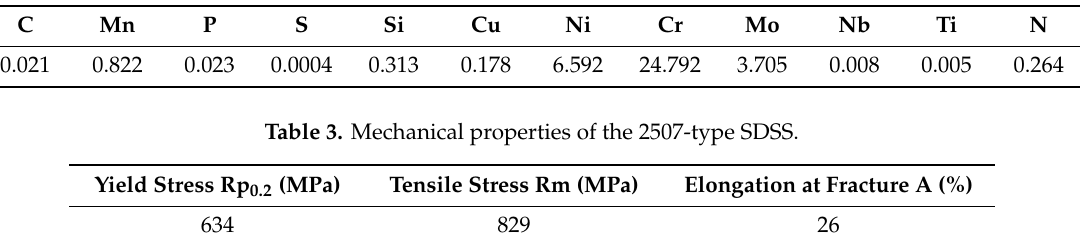
Table 2. Chemical composition of the 2507-type SDSS (%).